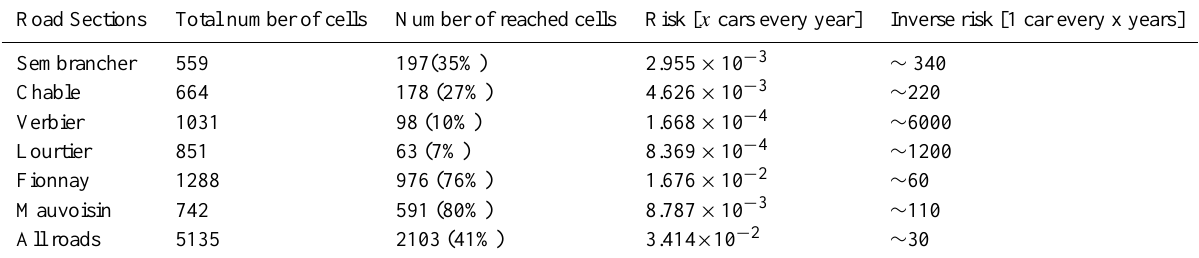
Table 4. Results of the quantitative risk assessment induced by rockfalls (mean diameter: 25cm) to vehicle traffic along road sections of the Val de Bagnes. Finally, the whole risk is defined as the sum of all calculated pixel.